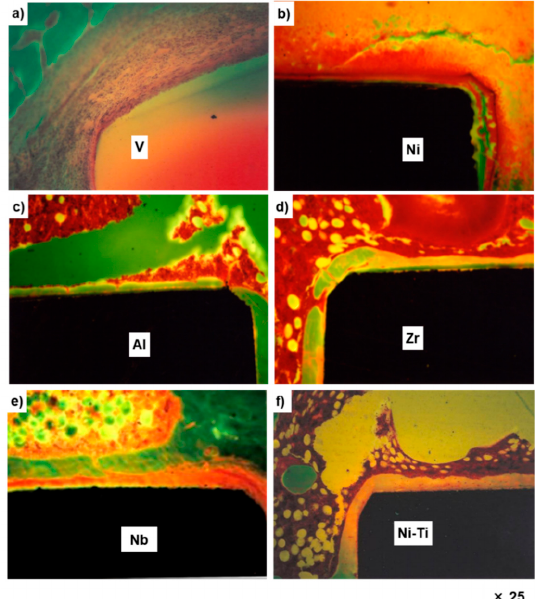
Figure 2. Optical micrographs of new bone formed around pure V ( a ), Ni ( b ), Al ( c ), Zr ( d ), and Nb ( e ) metals and Ni–Ti alloy ( f ) after 52 weeks. Black shadows show implanted metals. For V, the implanted specimen was lost during the preparation of the